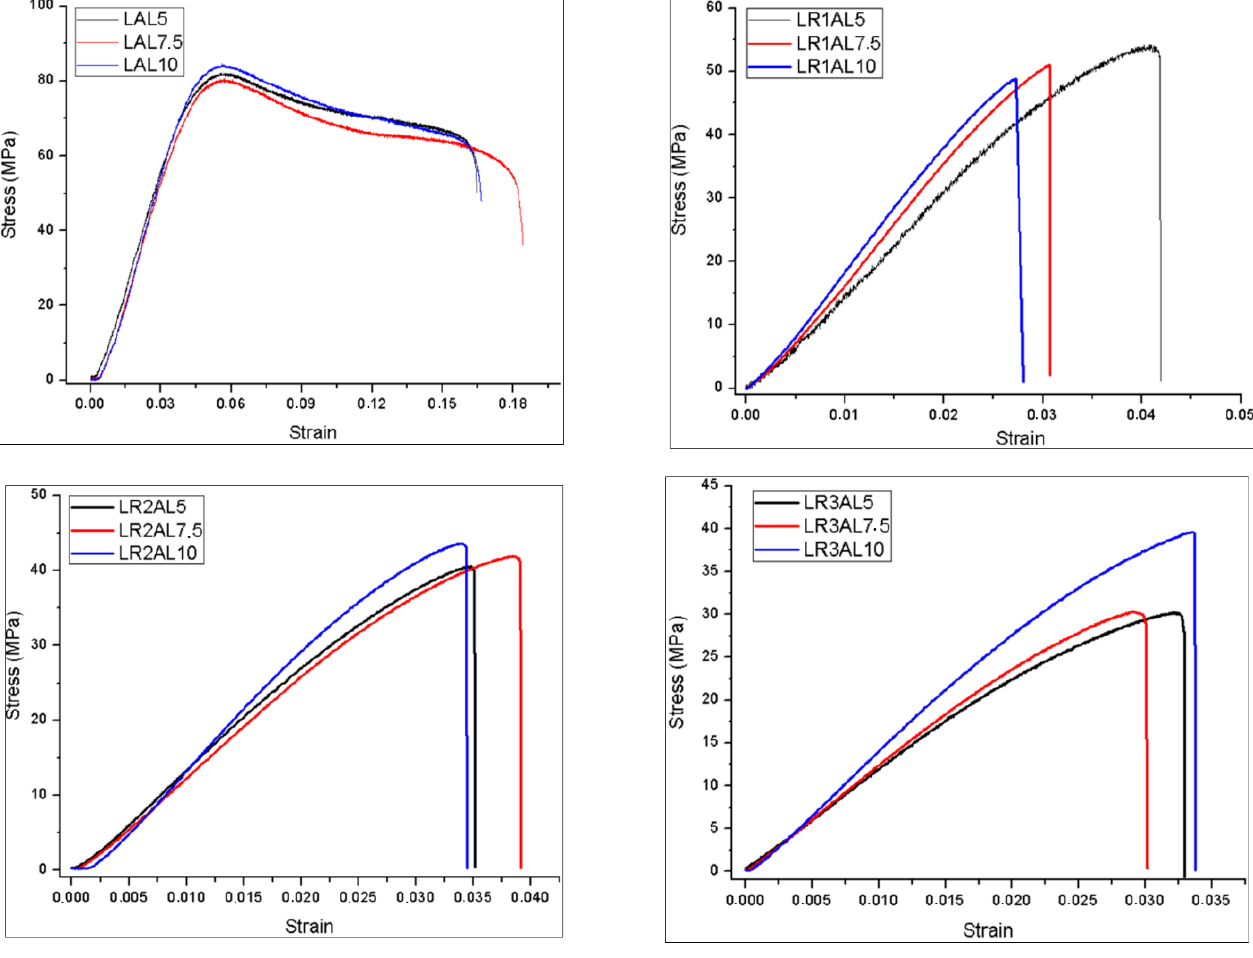
Figure 5. Stress-strain curves of the recycled rubber composites reinforced with AFs (LRAL) [53].